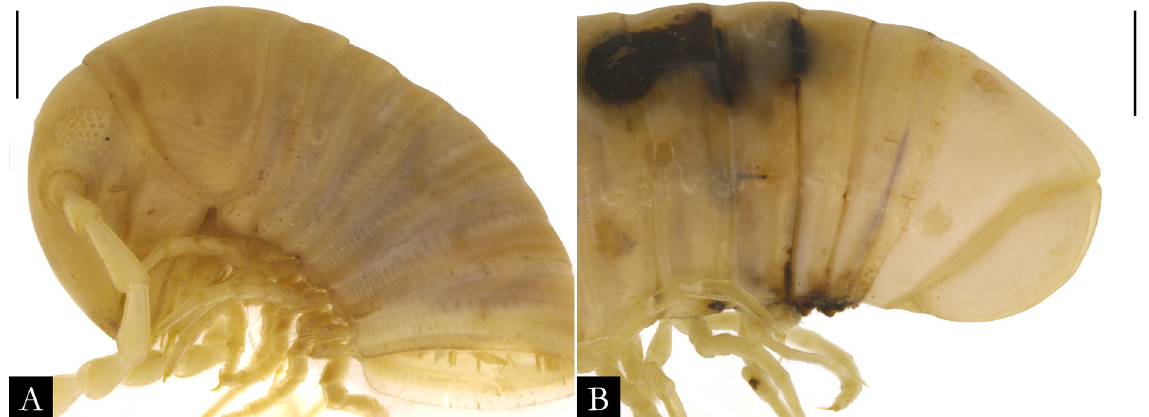
Fig. 72. Pseudonannolene imbirensis Fontanetti, 1996, paratype, ♀ (MZSP 1030), in lateral view. A . Anterior region. B . Posterior region. Scale bars = 1